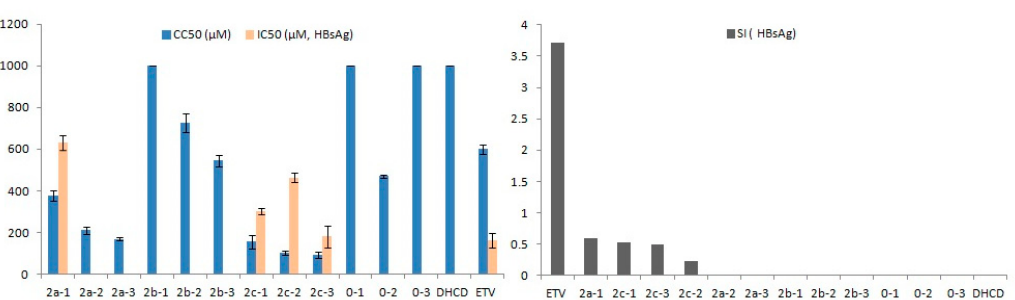
Figure 2. Cytotoxicity, inhibiting HBsAg activity and selectivity index (SI, right) of compounds.